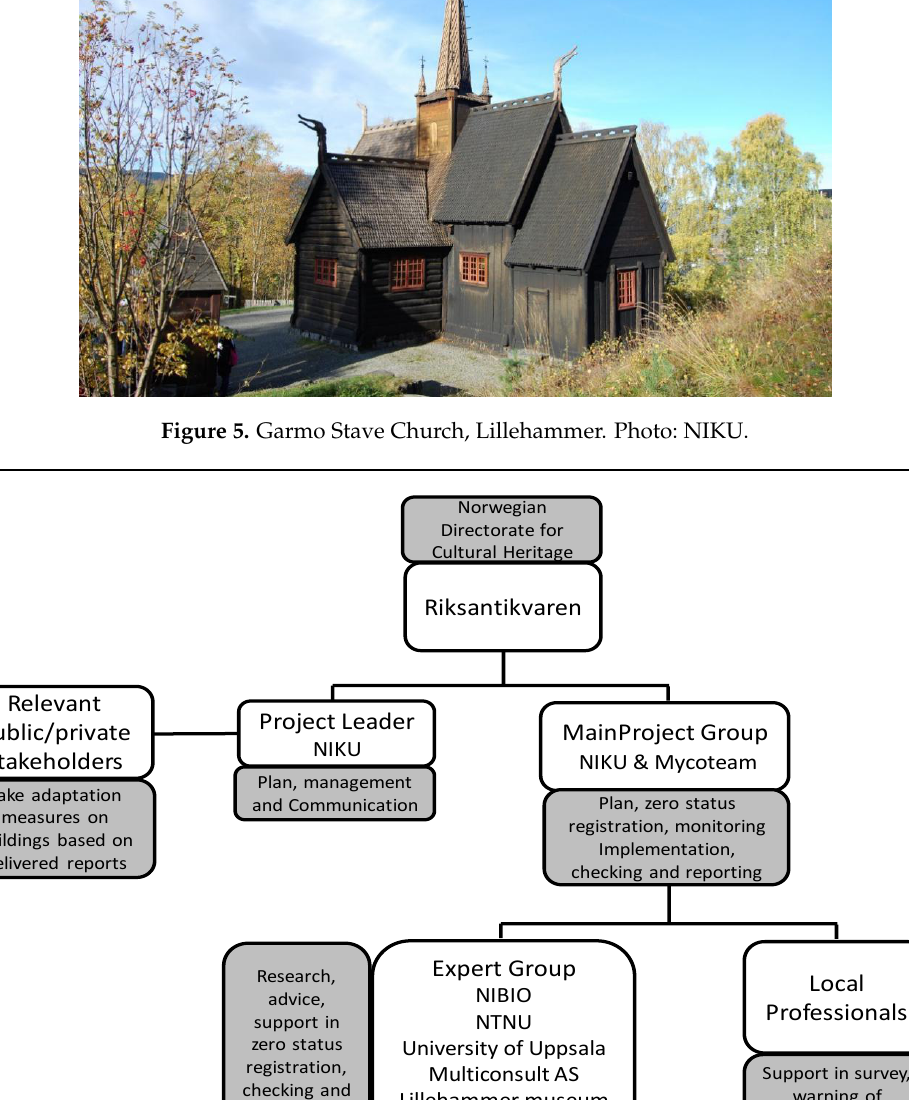
change on protected buildings—Miljøovervåkning av konsekvensene av klimaendringene på fredete